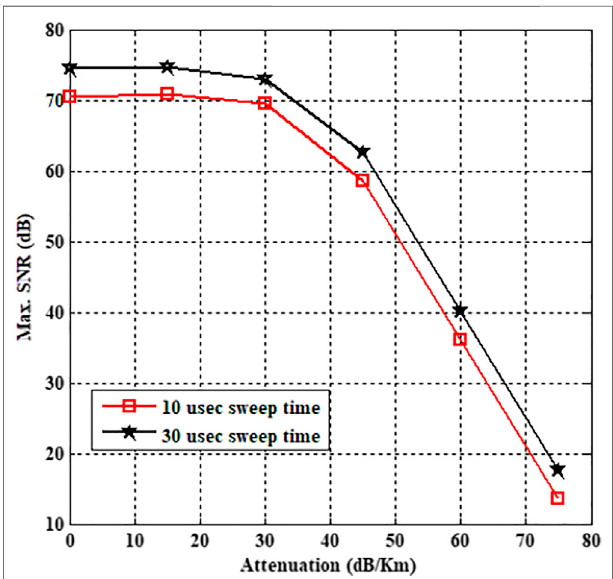
FIGURE 7 | Measured SNR at 10 and 30 µsec sweep